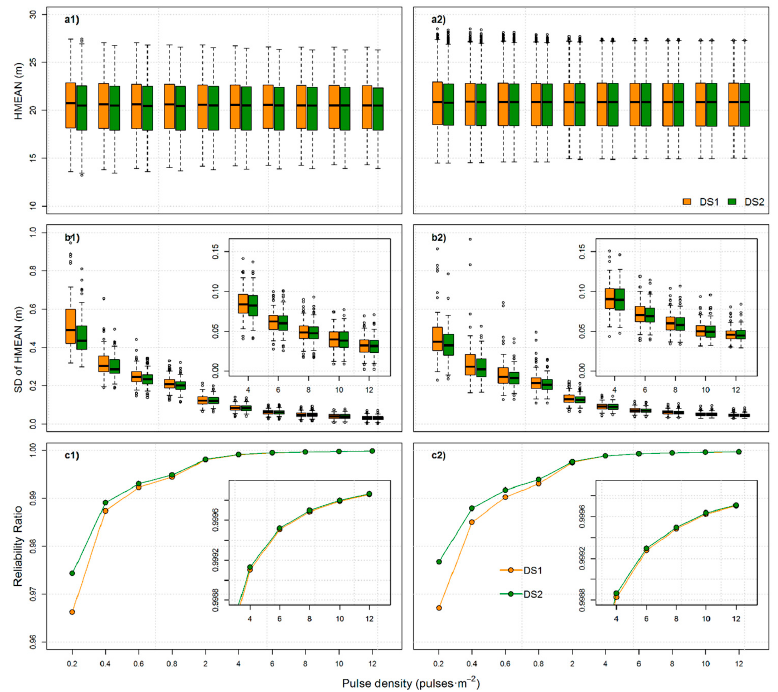
Figure 4. Lidar-derived HMEAN (m) ( a1-2 ); Standard deviation of HMEAN (m) for the sample plots